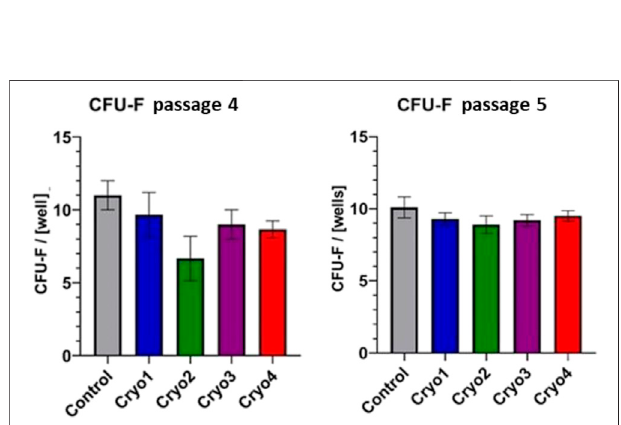
FIGURE 3 | Comparison of PDTs of the non-frozen (Control) and frozen with cryoprotectans 1 through 4 (Cryo 1 through Cryo 4) AT- MSCs from passages 4 and 5. Mean values ± SEM are shown. The PDT analysis was performed from 5 samples.